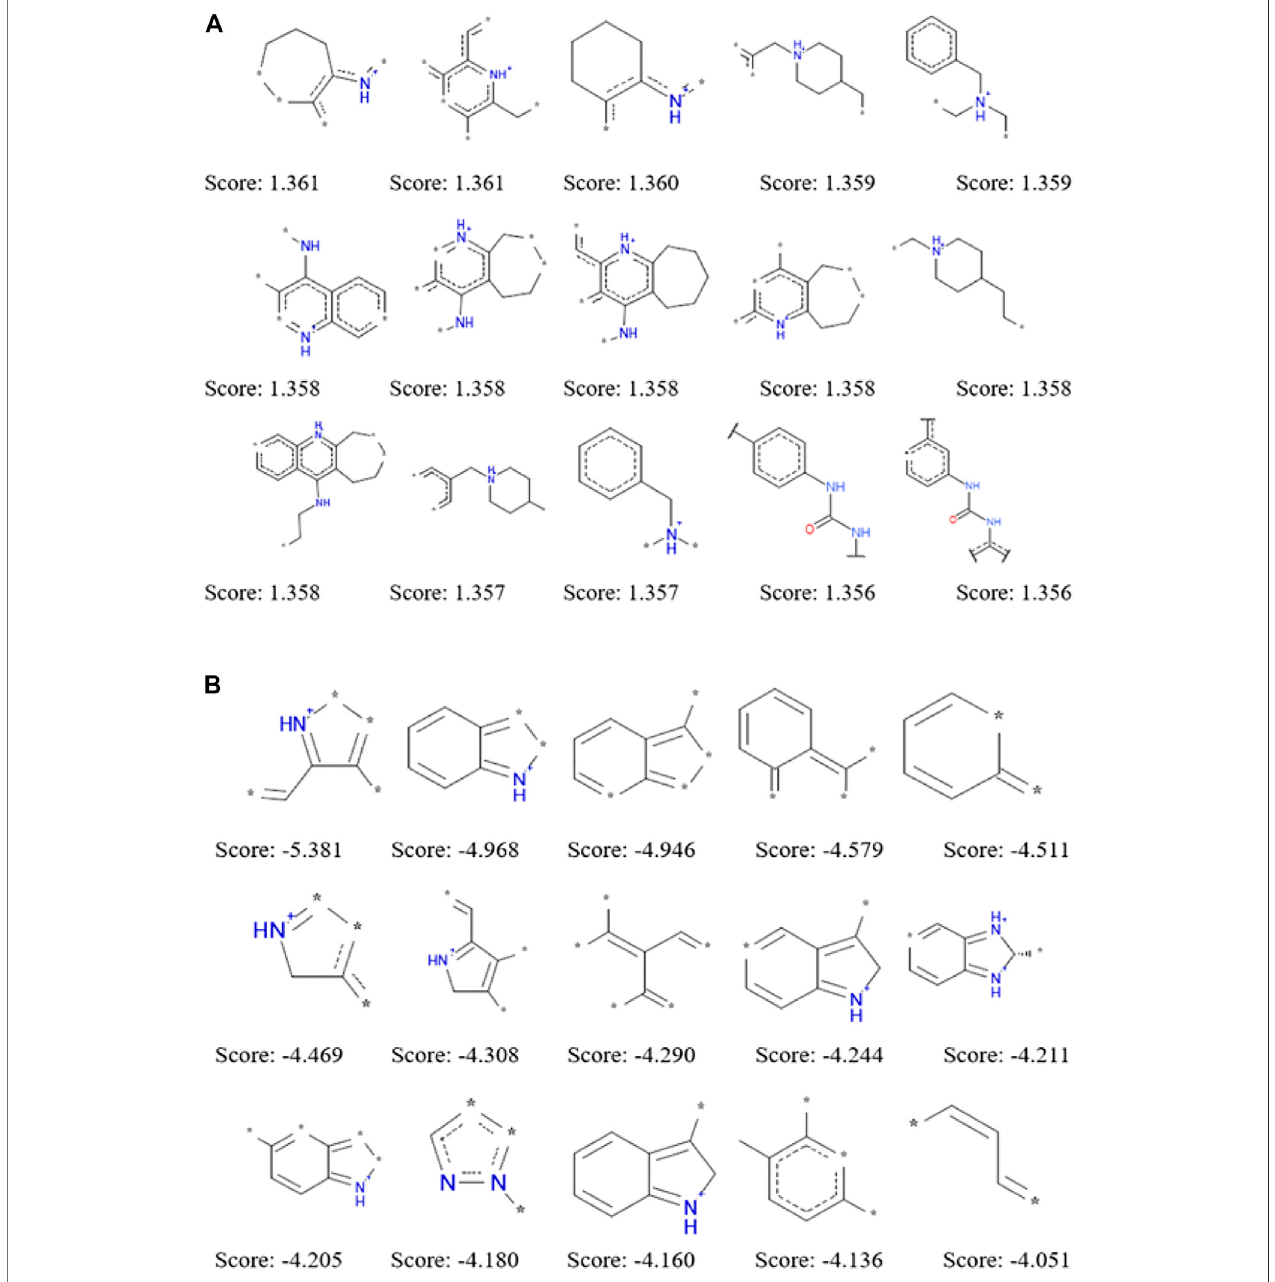
FIGURE2| Examplesofthetop15good (A) andbad (B) fragmentsforACHEinhibitionasestimatedbyNB(ECFP_6)model.TheBayesianscore(Score)isgivenfor each fragment.